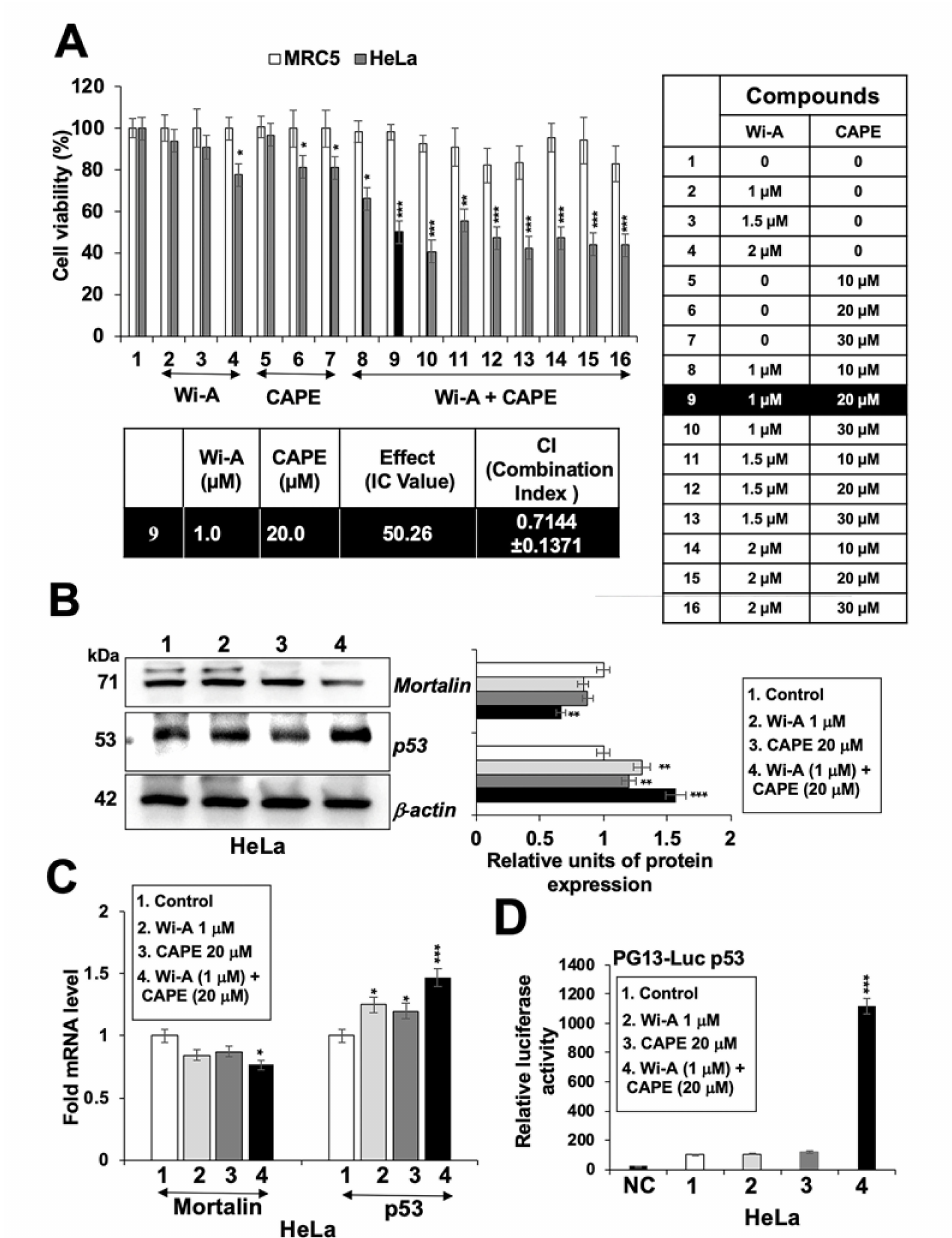
Figure 4. Combination of Withaferin A (Wi-A) and ca ff eic acid phenethyl ester (CAPE) possesses stronger cytotoxicity. 3-(4,5-dimethylthiazol-2-yl)-2,5-diphenyl tetrazolium bromide (MTT)-based cell viability assay showing dose dependent cytotoxicity either Wi-A or CAPE alone, or in combination in MRC5 and HeLa cells ( A ). Wi-A, CAPE, and their combination showed decrease in mortalin and increase in p53 protein ( B ) and mRNA levels ( C ). Wild type p53 protein-driven luciferase reporter (PG13-Luc) assay showed remarkable increase in cells when treated with the combination ( D ). Data were normalized against the control and plotted as fold and percent di ff erence. Each data set represents the mean ± SD for at least three independent experiments. Statistical significance was defined as p -values (*) where * < 0.05, ** < 0.01 and *** < 0.001 represent significant, very significant and highly significant,